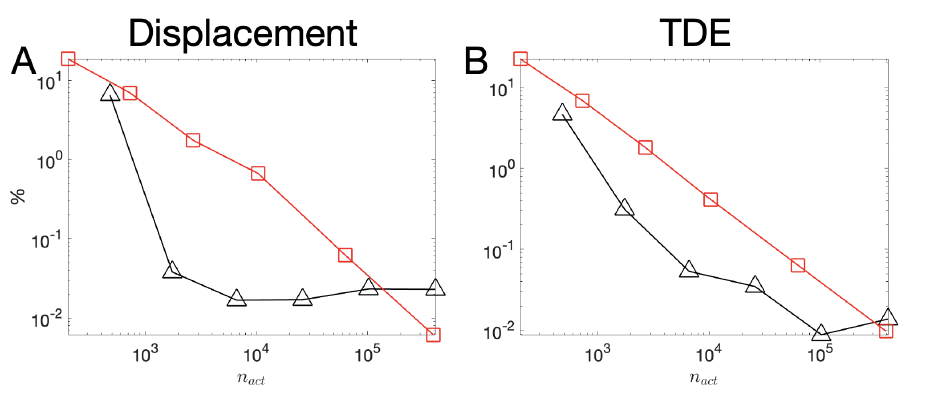
Figure 7. Relative error of ( A ) displacements magnitude and ( B ) TDE obtained for the IBR (black) and classical FE (red)